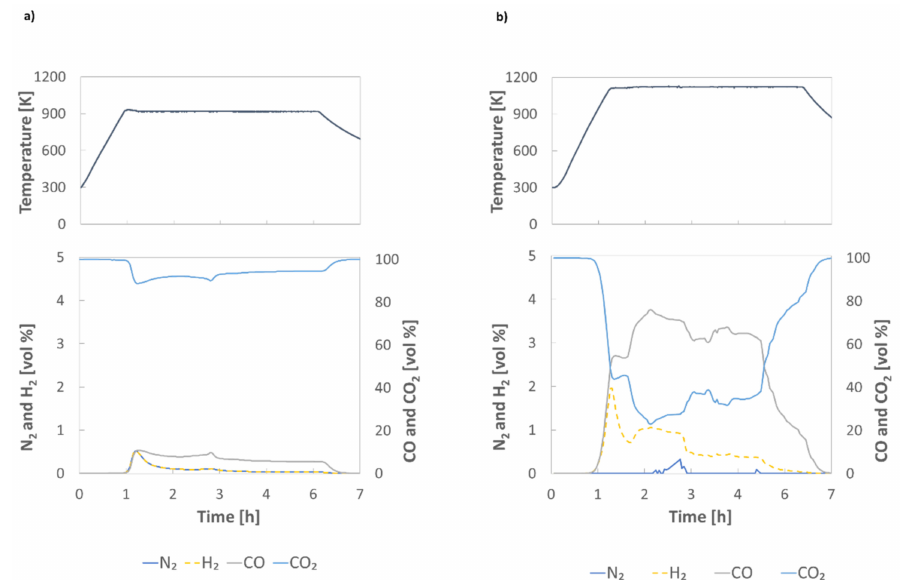
Figure 4. Tests in CO 2 at ( a ) 973 K and ( b ) 1173 K. Gas composition at the reactor outlet (N 2 , H 2 , CO and CO 2 volumetric